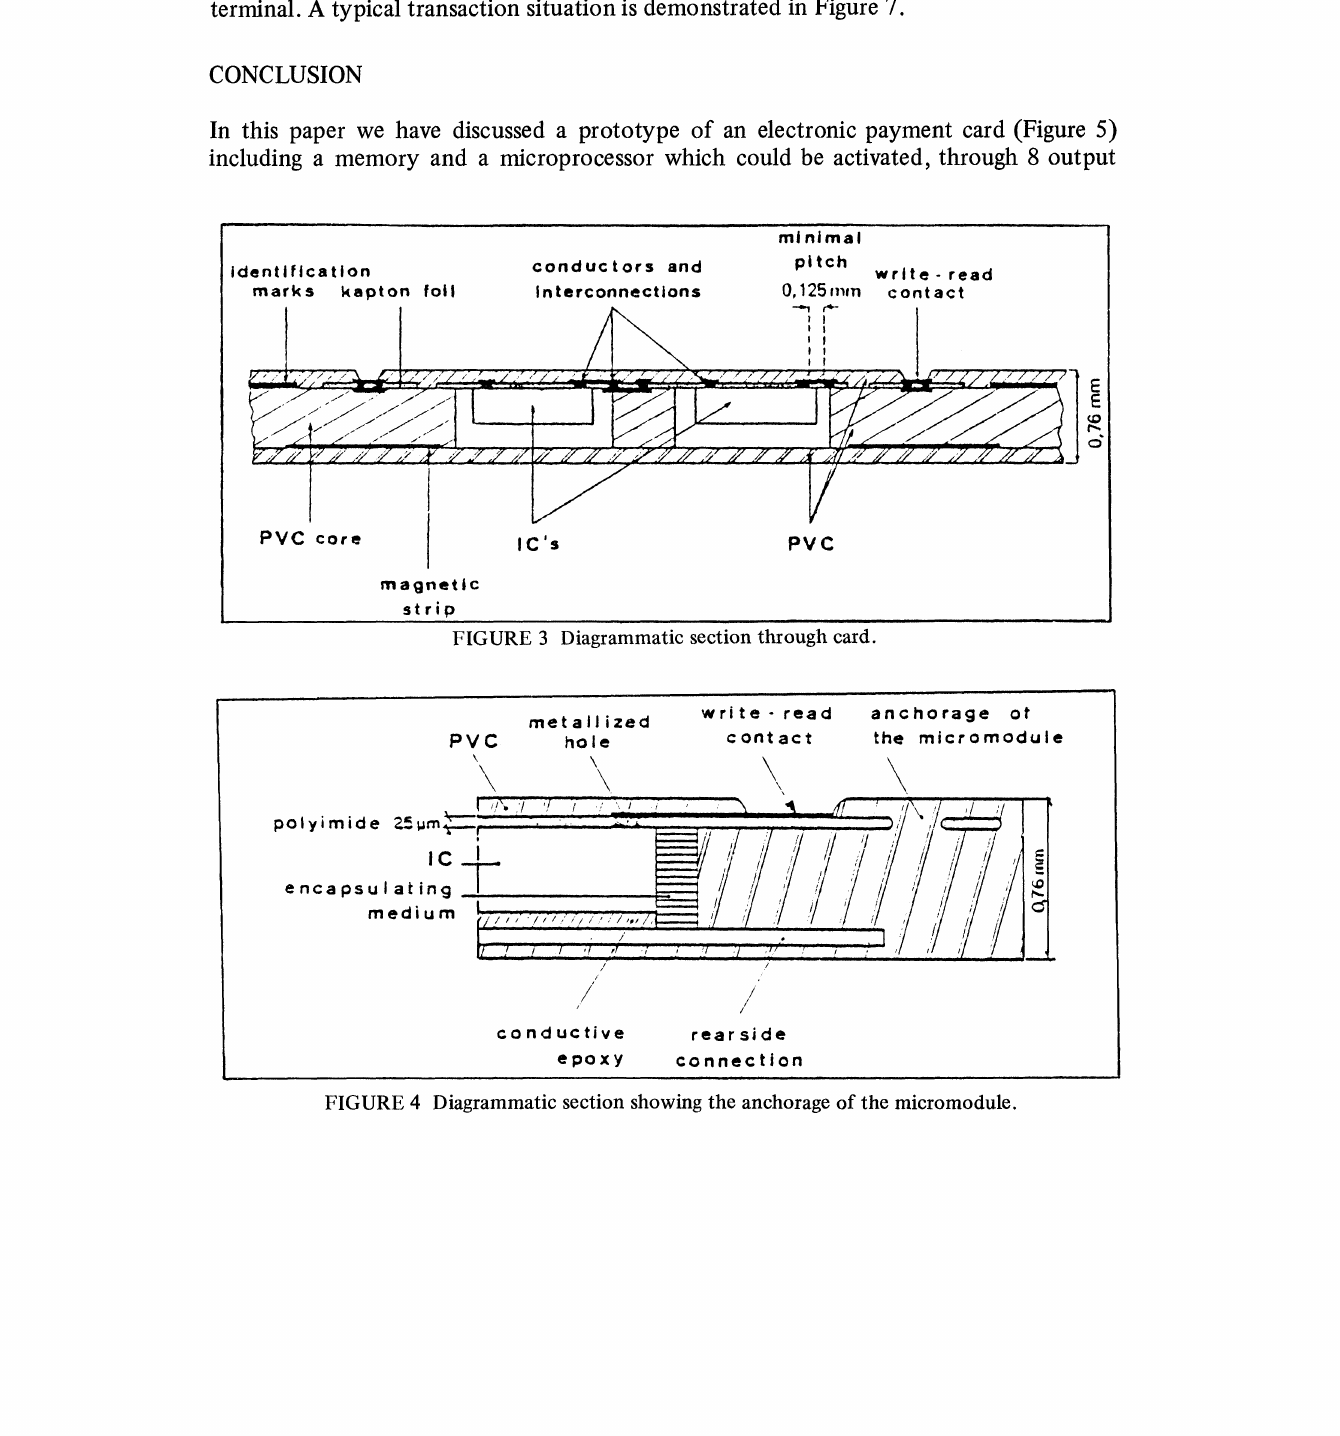
FIGURE 3 Diagrammatic section through card.